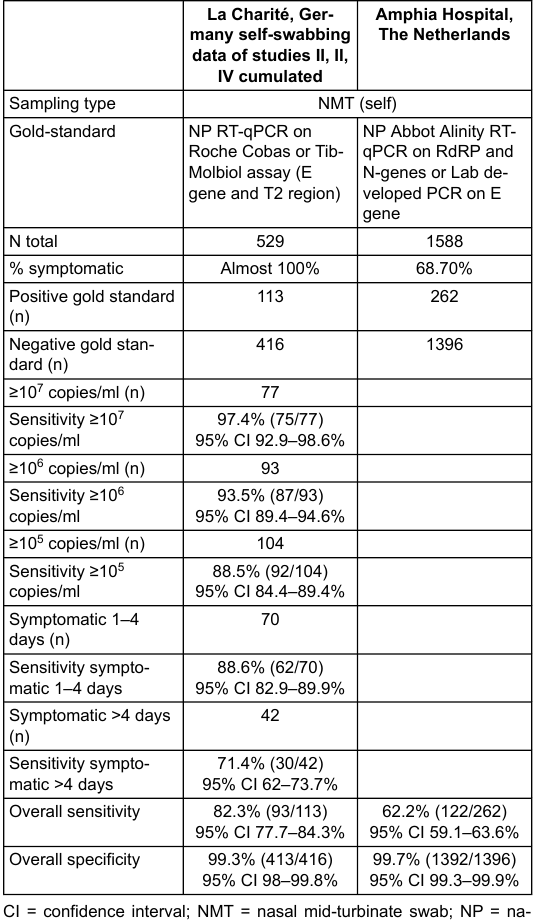
Table 2: Data concerning testing of self-collected nasal mid-turbinate